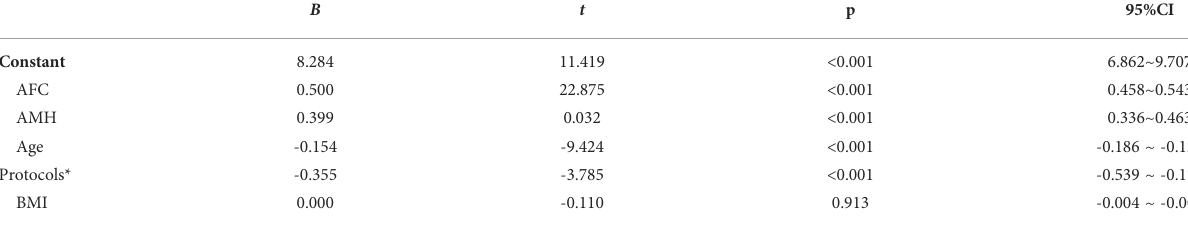
TABLE 2 Analysis of the factors affecting the number of retrieved oocytes by multivariate-linear regression (stepwise method). B t